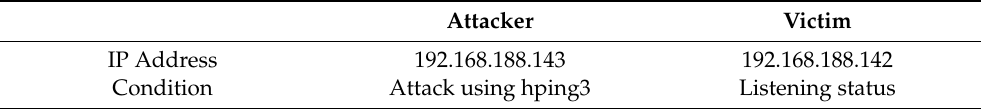
Table 18. IP address and status of the attacker and